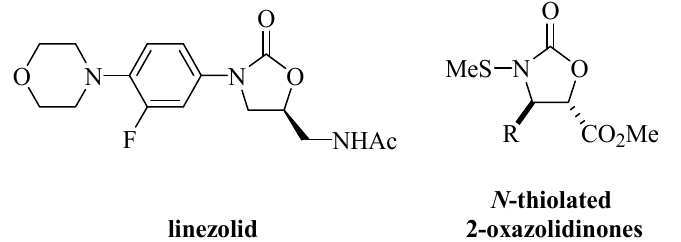
Figure 2. Structures of the linezolid and N -thiolated